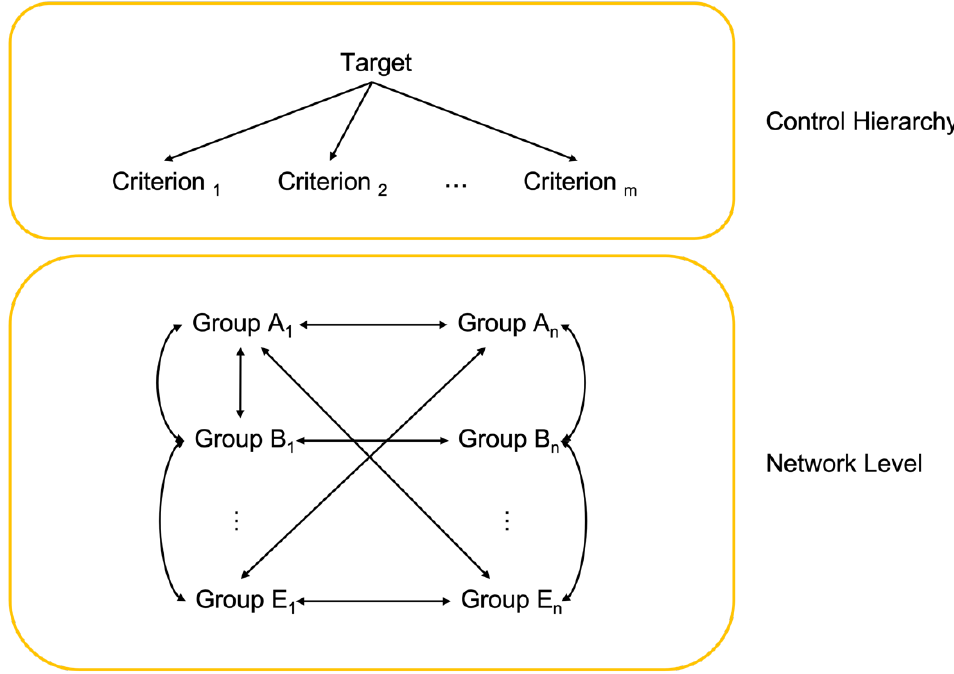
Figure 1. The system structure of the ANP